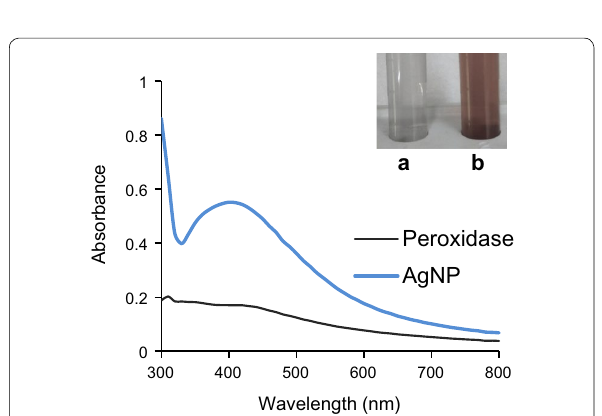
Fig. 4 UV–Vis spectrum of purified lignin peroxidase and synthesized AgNPs. Inset: Color change showing AgNP synthesis by purified enzyme on addition of silver nitrate a control, and b after AgNP